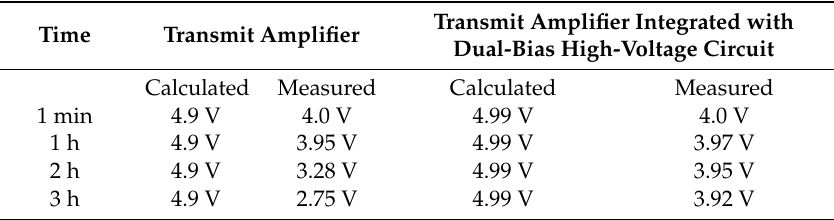
Table 1. Measured DC bias voltages of the transmit amplifier with and without dual-bias high-voltage circuit.